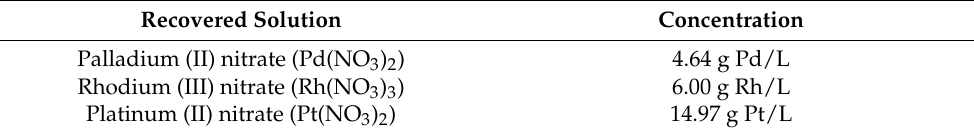
Table 4. Description of the recovered metal solutions delivered by the partners of PLATIRUS pro- ject.